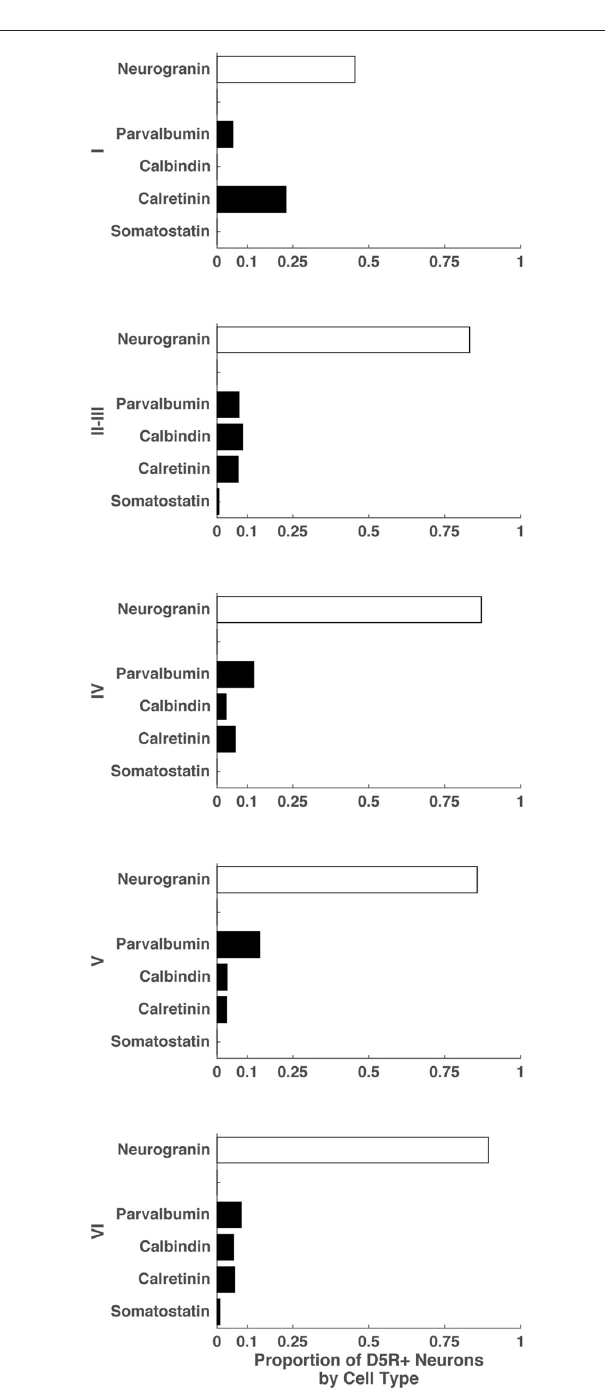
FIGURE 4 | Proportion of D5R+ neurons by cell type for different cortical layers. For cortical layers I, II–III, IV, V and VI: proportion of D5R+ cells that express a given cell type marker (SMI-32, neurogranin, parvalbumin, calretinin, somatostatin).